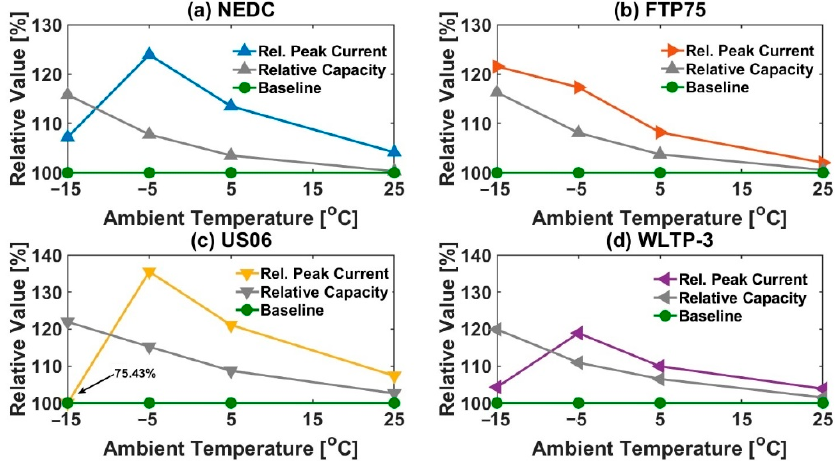
Figure 6. Comparing relative peak current & relative capacity discharged from cell to baseline peak current and relative capacity demanded for various legislative drive cycles at different ambient temperatures for 65% starting SOC employing power-based approach: ( a ) NEDC, ( b ) FTP75, ( c ) US06 and ( d ) WLTP-3.